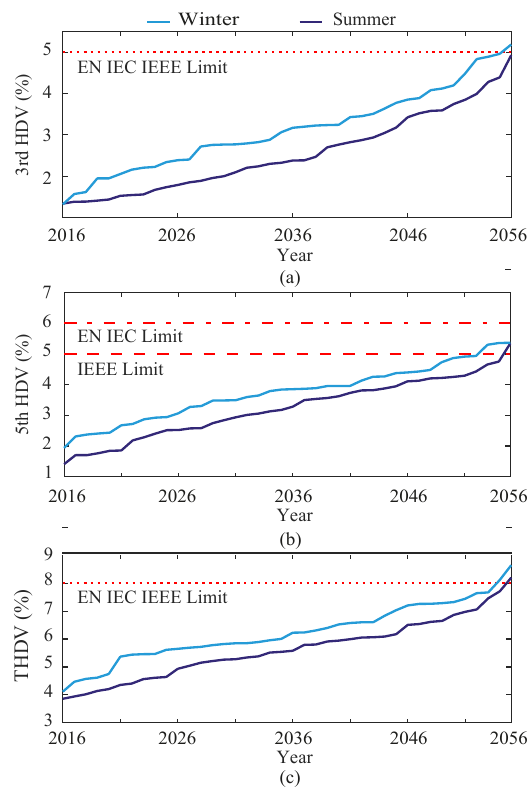
Figure 15. The estimation of harmonic voltage distortion in the next 40 years: the 95 percentile value. ( a ) 3rd; ( b ) 5th; and ( c ) total harmonic distortion of voltage ( THDV